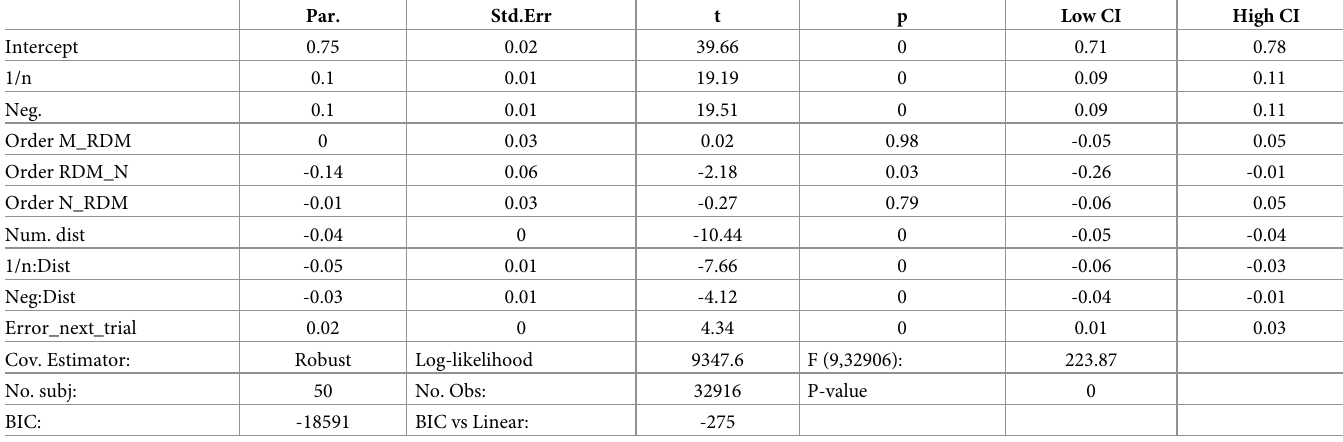
Table 1.2. RT. Exp. 1 . Random Effects Estimation.